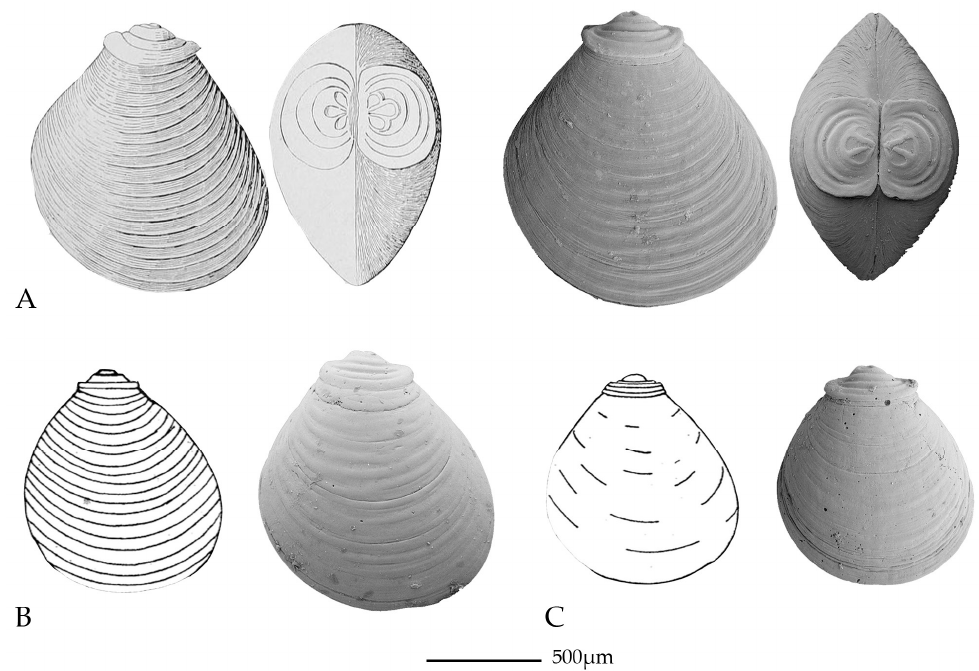
Figure 5. The utility of SEM for harvesting rich micromolluscan character data. Synonymised types of Austrocardiella trifoliata (from [71]). ( A ) Original drawings of Condylocuna trifoliata (from [71]); ( B ) Condylocuna cambrica (in [19]); and ( C ) Benthocardiella vitrea (from [19]), compared with SEM [43].